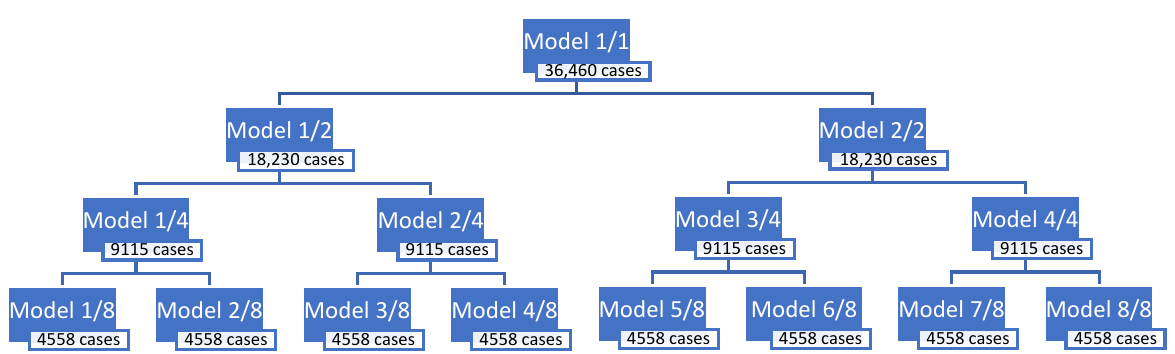
Figure 3. The scheme of the division into sub-ranges for the Zabrze station.